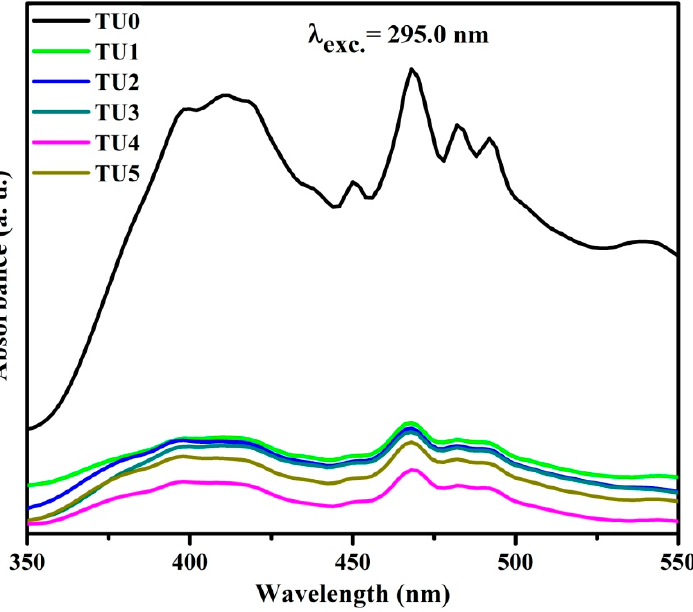
Figure 6. Photoluminescence (PL) spectra of TU0, TU1, TU2, TU3, TU4 and TU5 ( λ exc. = excitation wavelength).